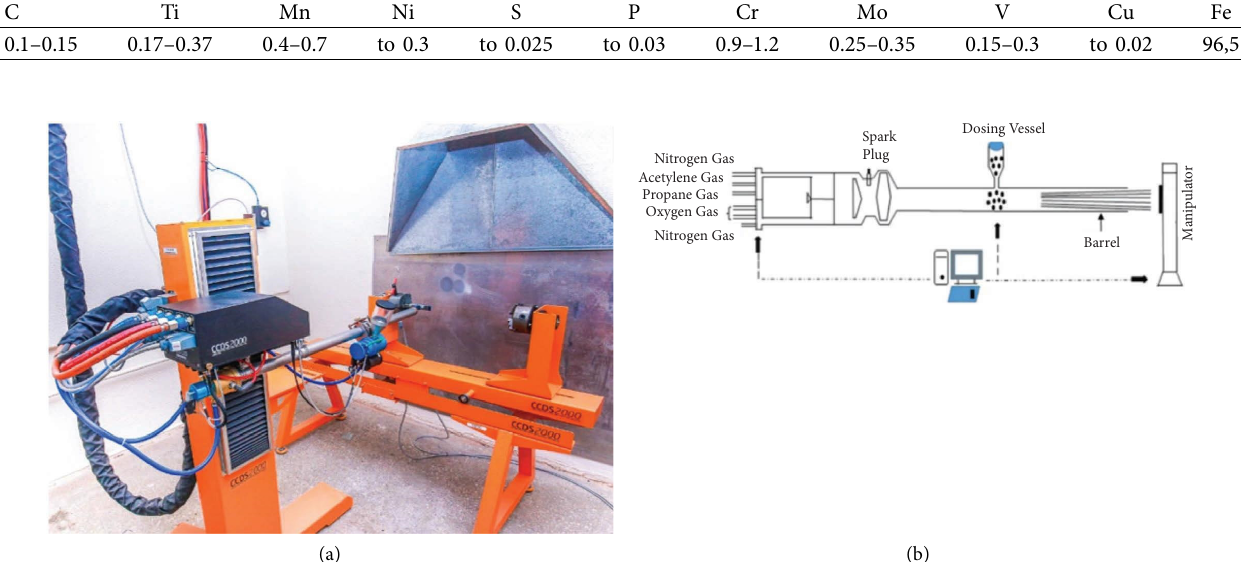
Table 2: Modes of coatings based on Cr